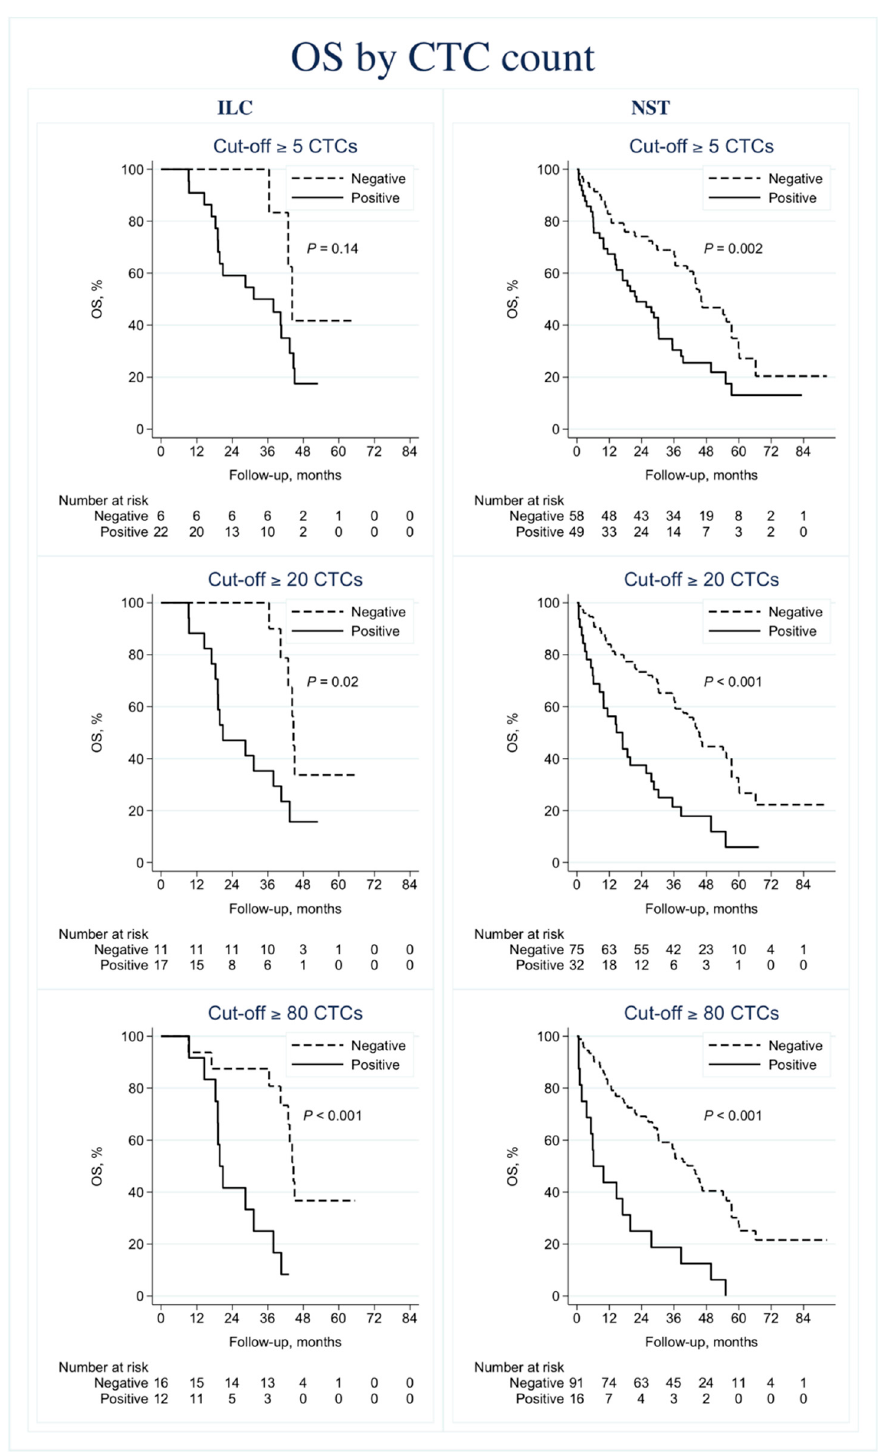
Figure 5. Overall survival (OS) by circulating tumor cell count. Kaplan–Meier plots displaying OS for the invasive lobular carcinoma (ILC) and invasive ductal carcinoma of no special type (NST) subgroups. Cut-off ≥ 5 CTCs ( A , B ). Cut-off ≥ 20 CTCs ( C , D ). Cut-off ≥ 80 CTCs ( E , F ).